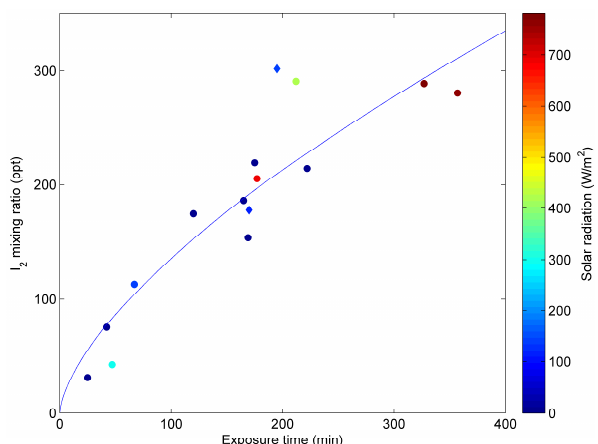
Fig. 3. I 2 mixing ratio above the A. nodosum and F. vesiculosus mixed beds observed at sampling site #1 at Mweenish Bay, Ireland, as a function of algal exposure time and solar irradiation. Each data point represents the mean value over a sampling period of 30min. Note the symbol solid circle represents data from this work, and solid diamond represents data from the 2007 campaign (Huang et al., 2010b). The O 3 concentrations in the surrounding air were 35– 39ppb over the course of measurements.